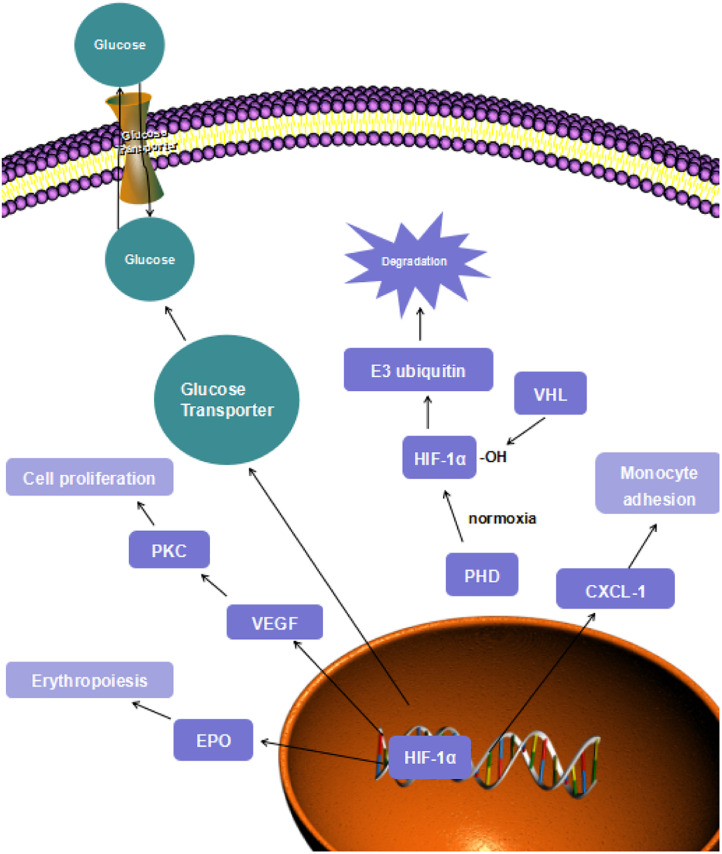
HIF-1α signaling.